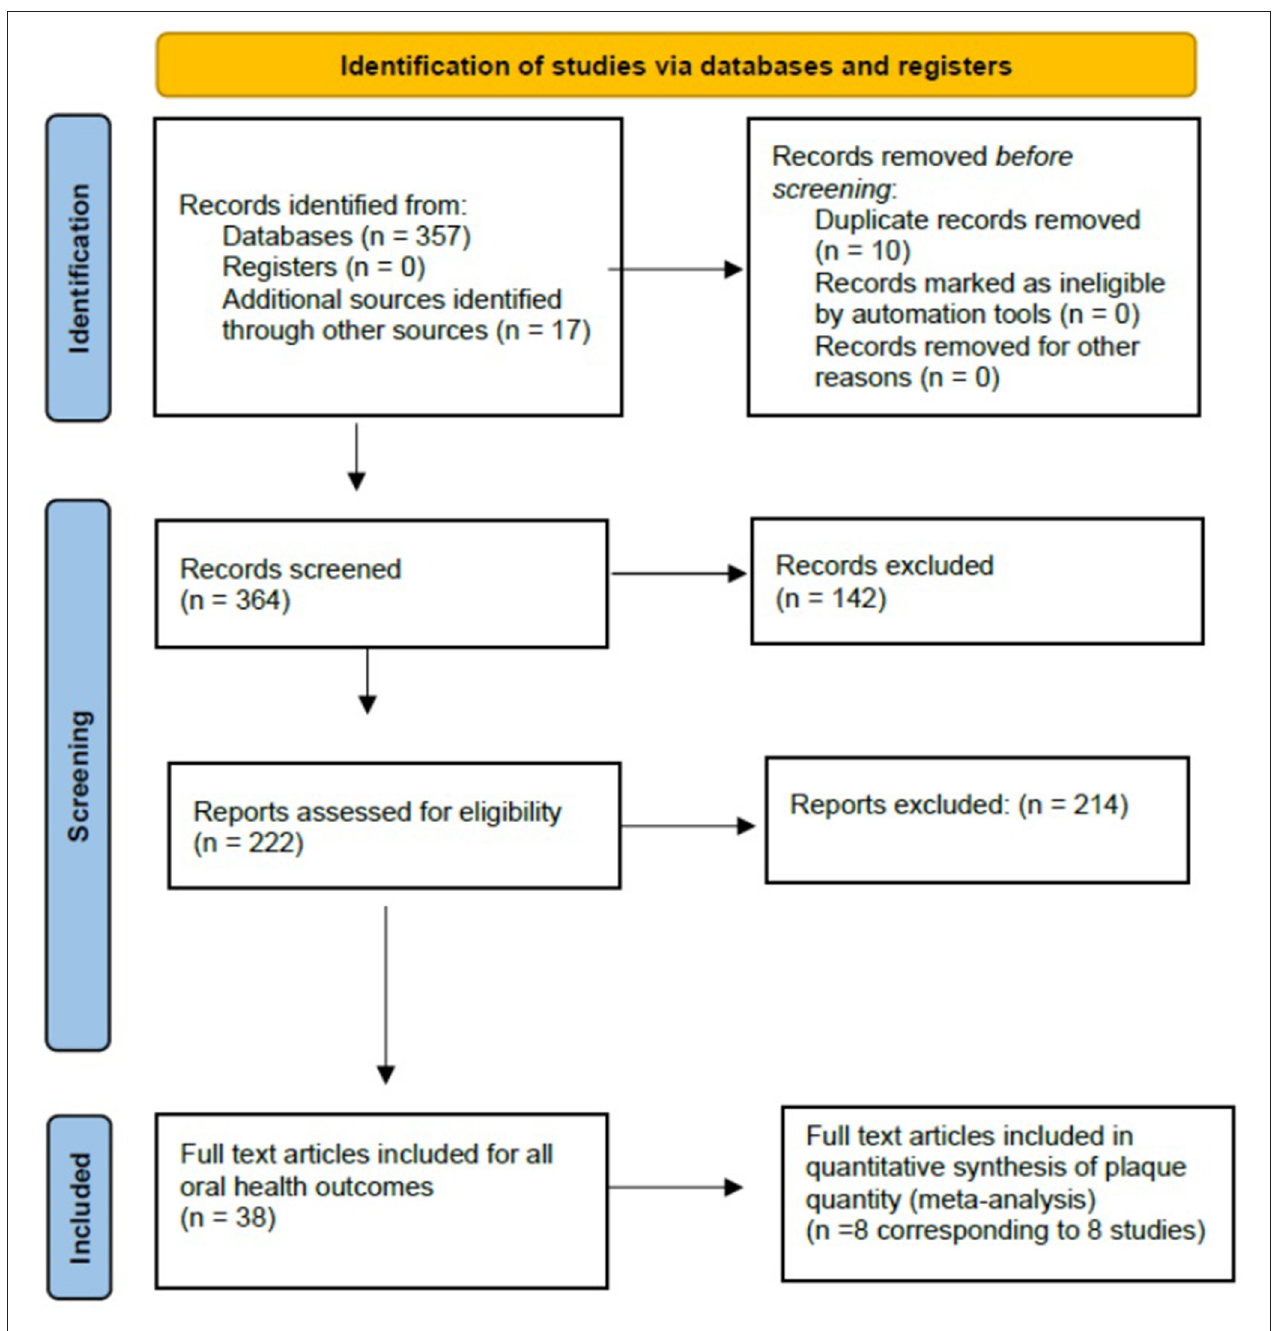
FIGURE 2 | PRISMA flowchart of study identification, screening and